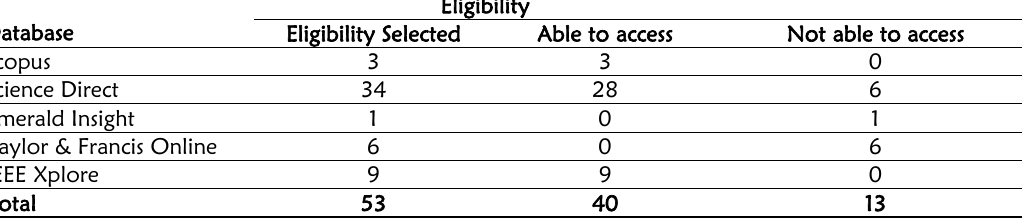
Table 7: Numbers of articles available to be access.